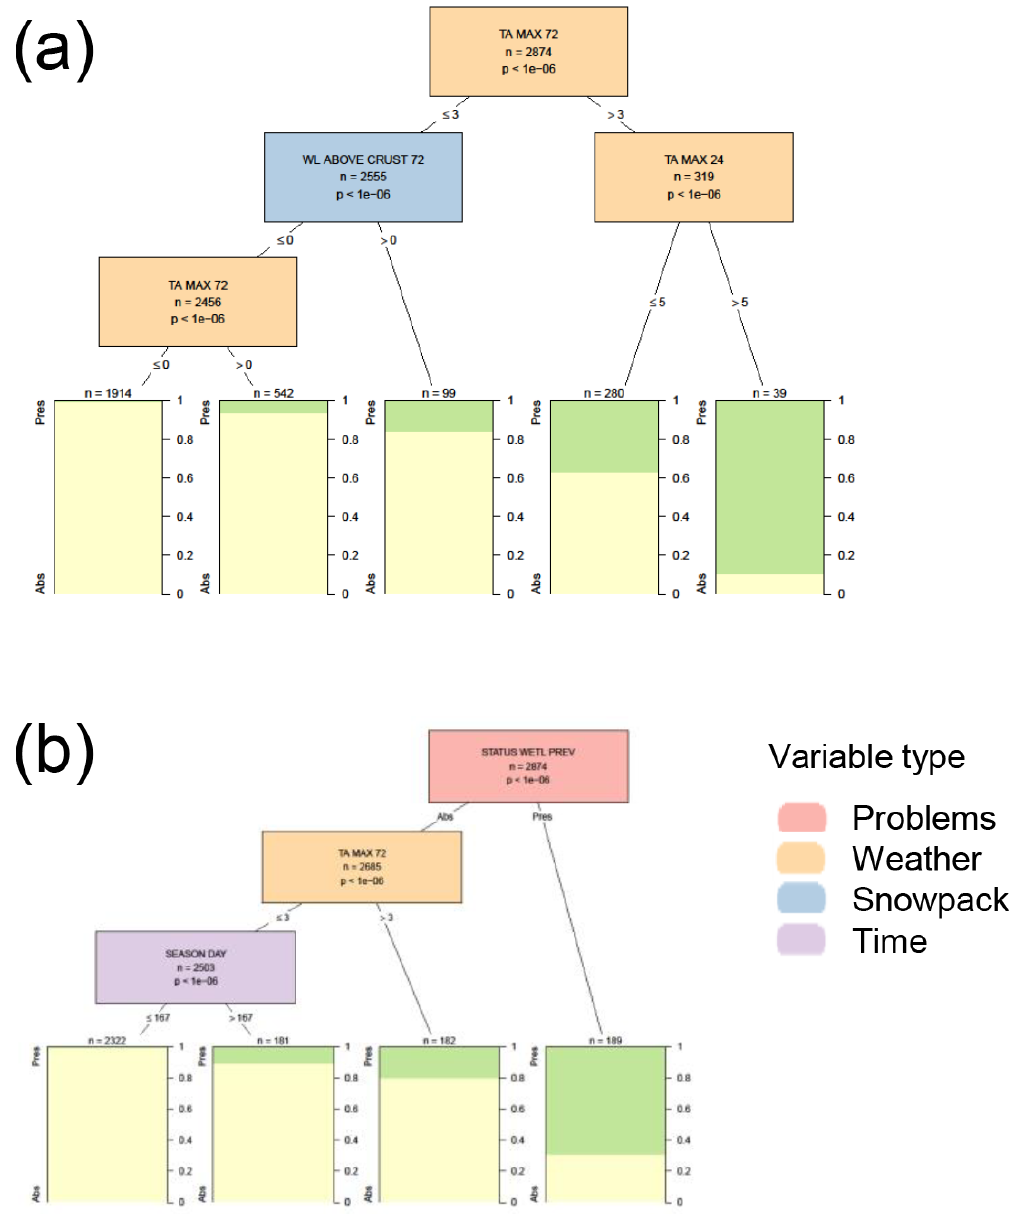
Figure C3. Conditional inference tree for the presence or absence (Pres/Abs) of wet loose avalanche problems (a) based on weather and snowpack variables and (b) including additional contextual variables about the hazard assessment. Variables appearing in the trees include the maximum air temperature over the past 24 and 72h (TA MAX 24 and TA MAX 72), whether there was a melt–freeze crust beneath the snow deposited in the past 72h (WL ABOVE CRUST 72), the presence or absence of a wet loose problem the previous day (STATUS WETL PREV), and the number of days since 1 October (SEASON DAY). Terminal nodes show the proportion of cases with wet loose problems present (green) and absent